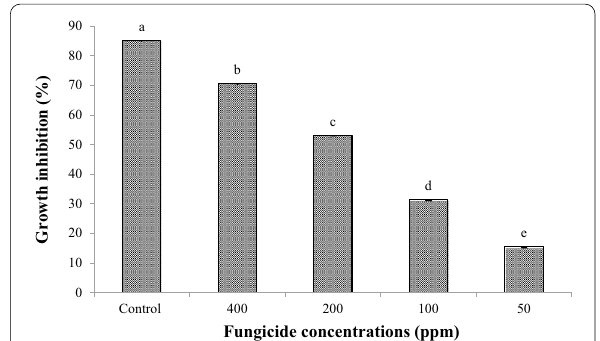
Fig. 1 In vitro application of fungicides against highly virulent isolate of Alternaria solani . Values followed by different letters indicate that means are significantly different from each according to fisher’s least significant difference at p 0.05. Error bars on graphs represent the = Mean